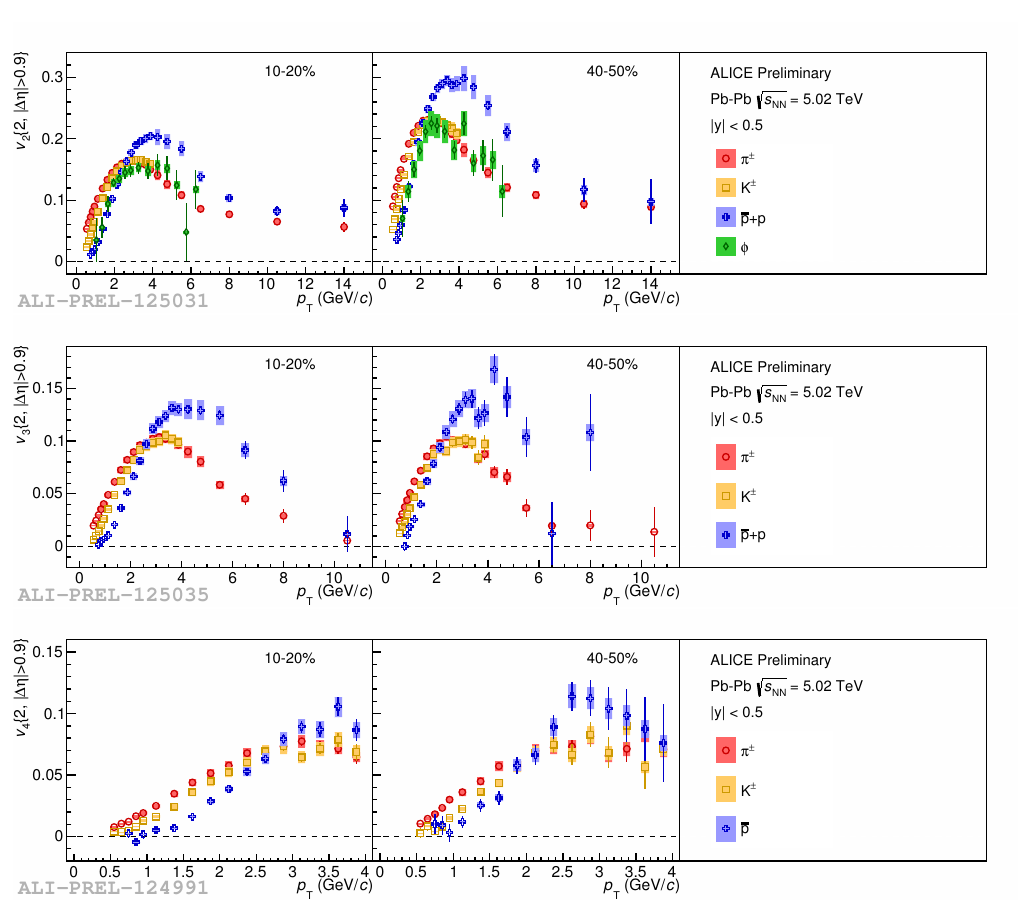
Figure 1. Flow coe ffi cient v 2 (top), v 3 (middle) and v 4 (bottom) of π ± , K ± , p(p) and the φ -meson for 10-20% (left) and 40-50% (right) collision centrality as function of p T . Statistical uncertainties are shown as bars and systematic uncertainties as